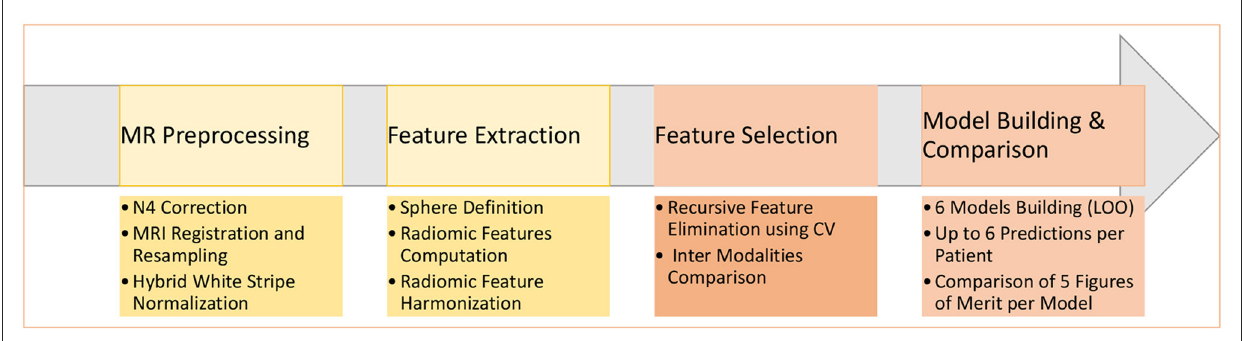
FIGURE2 Main steps of the construction of the six machine learning models to predict a molecular